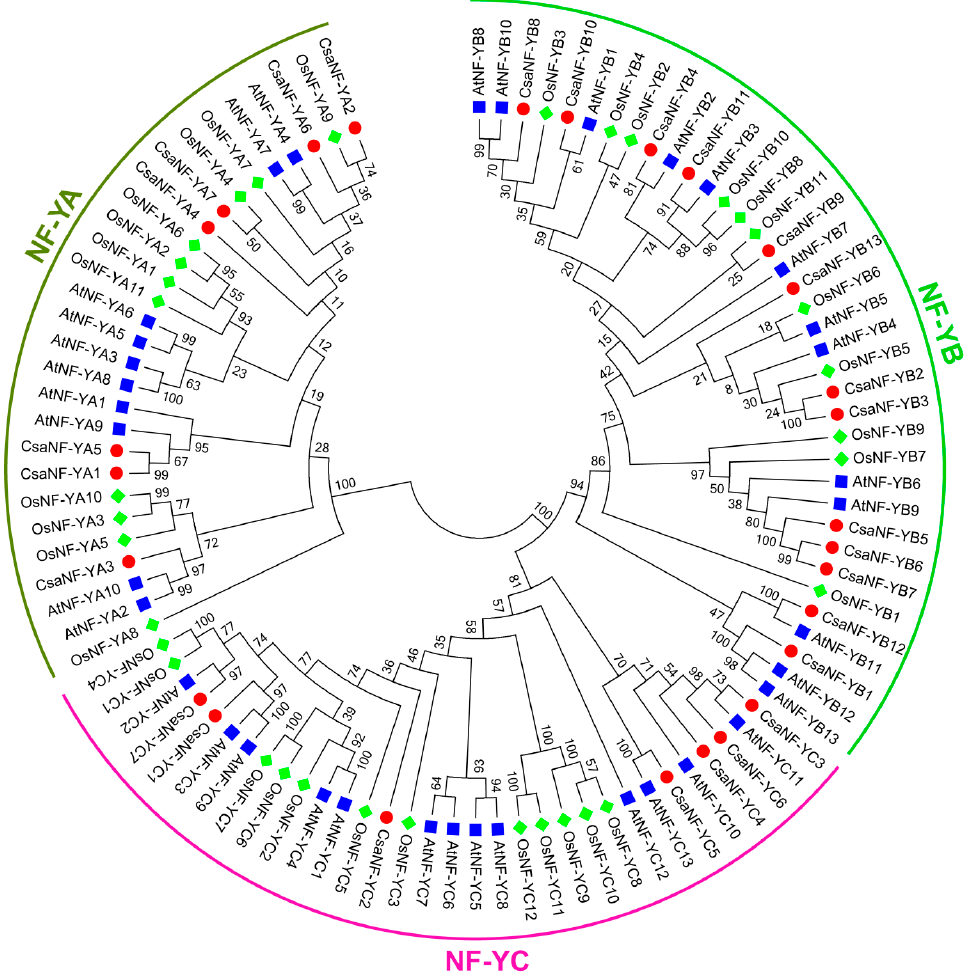
Figure 1. Phylogenetic analysis of NF-Y gene family among cucumber, Arabidopsis , and rice. Full-length NF-Y proteins from cucumber, Arabidopsis , and rice were aligned using MAFFT, and the phylogenetic tree was created with MEGA 7.0 by the neighbor joining (NJ) method with 1000 bootstrap replicates. The protein IDs from Arabidopsis and rice are listed in Table S2. All the CsaNF-Y genes were distributed throughout all seven chromosomes of cucumber, except (seven genes each), followed by chromosome 1 (five genes), and two chromosomes (chromosomes 4